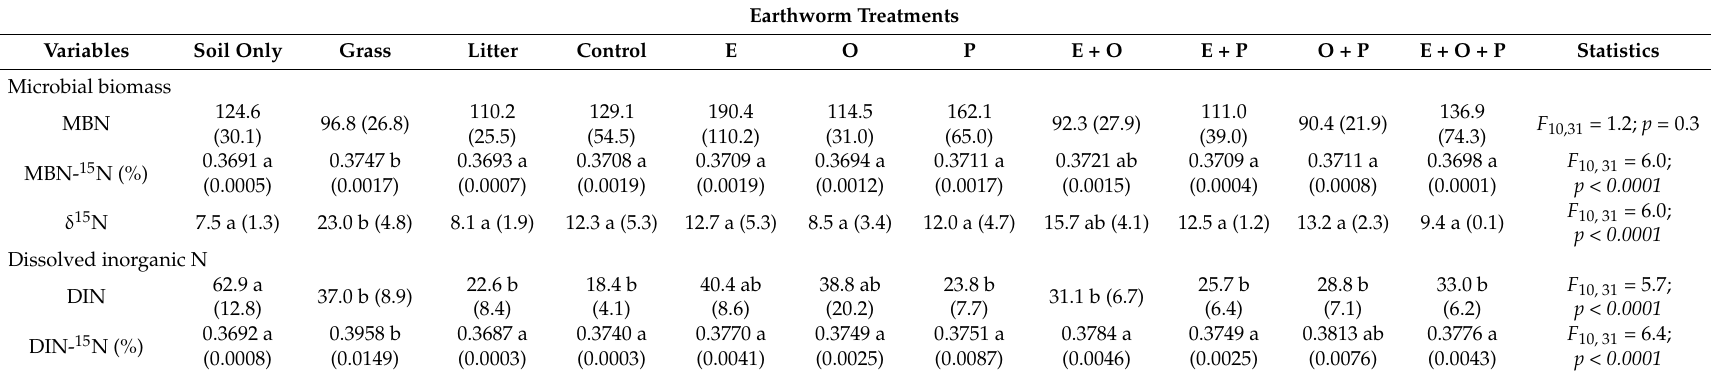
Table 6. Soil microbial total nitrogen (MBN; µ g N/g soil), atom percentage of 15 N (MBN- 15 N; %), and delta 15 N ( δ 15 N; ‰) signature and dissolved inorganic nitrogen (DIN; µ g N/g soil), and atom percentage of 15 N (DIN- 15 N; %) in DIN from the control treatments (Soil Only, soil with 15 N-labeled grass (Grass), soil with 13 C-labeled leaf litter (Litter), and Control (soil with grass and leaf litter but no worms)) and earthworm treatments at the end of the 22-day mesocosm experiment with Puerto Rican soils. See Table 5 for definitions of